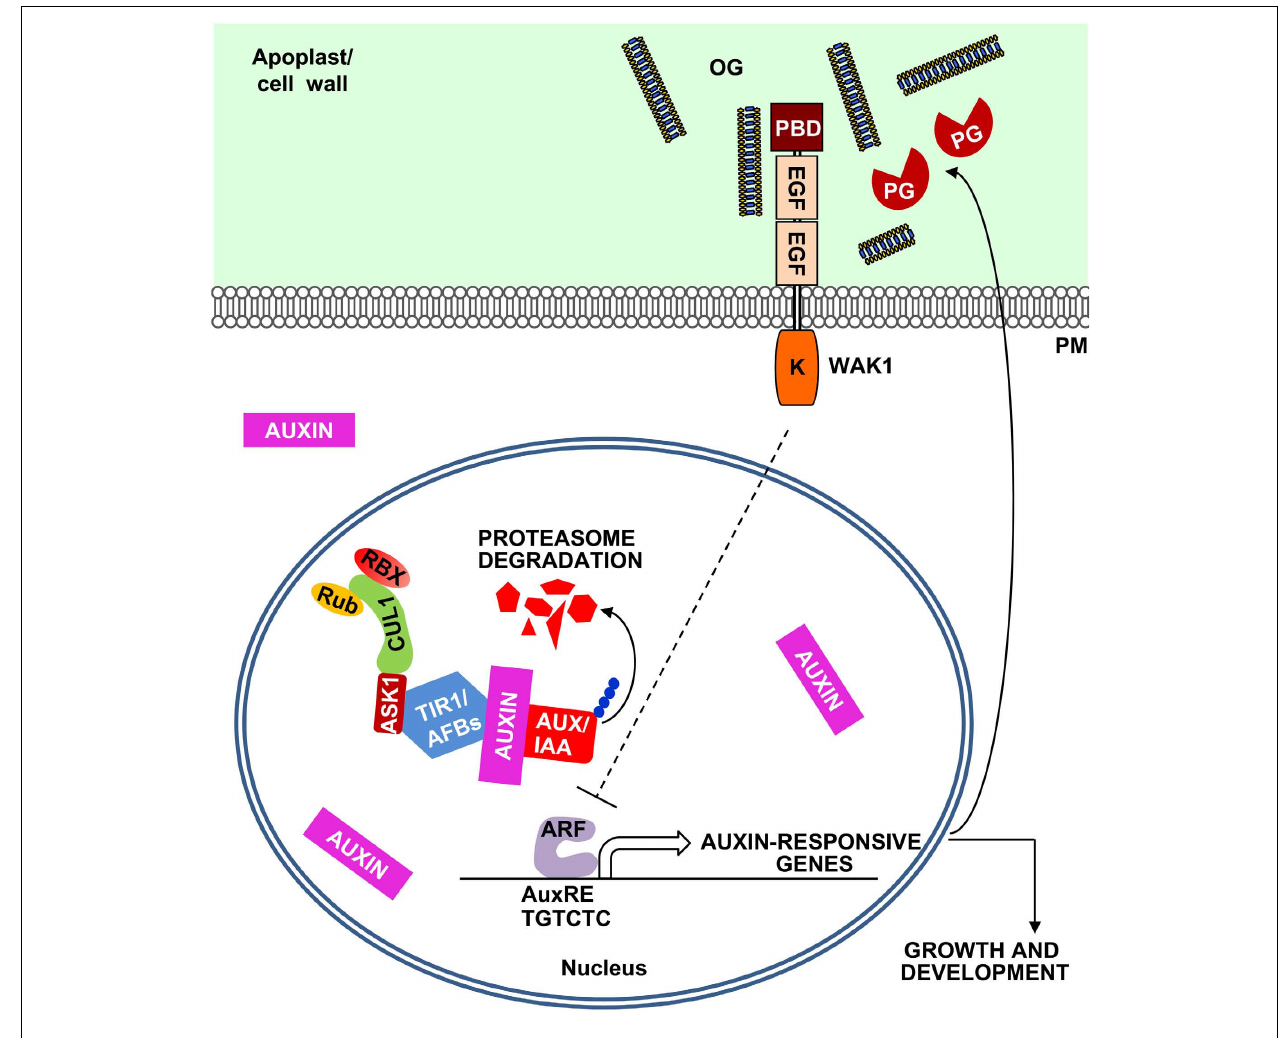
FIGURE 2 |A model for the OG-mediated negative feedback regulation of the auxin responses. Plant cells sense auxin through the receptors TIR1/AFBs, F-box proteins that form a SCF E3 ubiquitin ligase complex together with SKP (ASK1) and CULLIN1 (CUL1).This complex is regulated by RUB1 conjugating enzyme (Rub) and RING BOX1 (RBX) proteins and, in the presence of auxin, leads to the ubiquitination of Aux/IAA repressors and their proteasome-mediated degradation. Aux/IAA degradation releases auxin